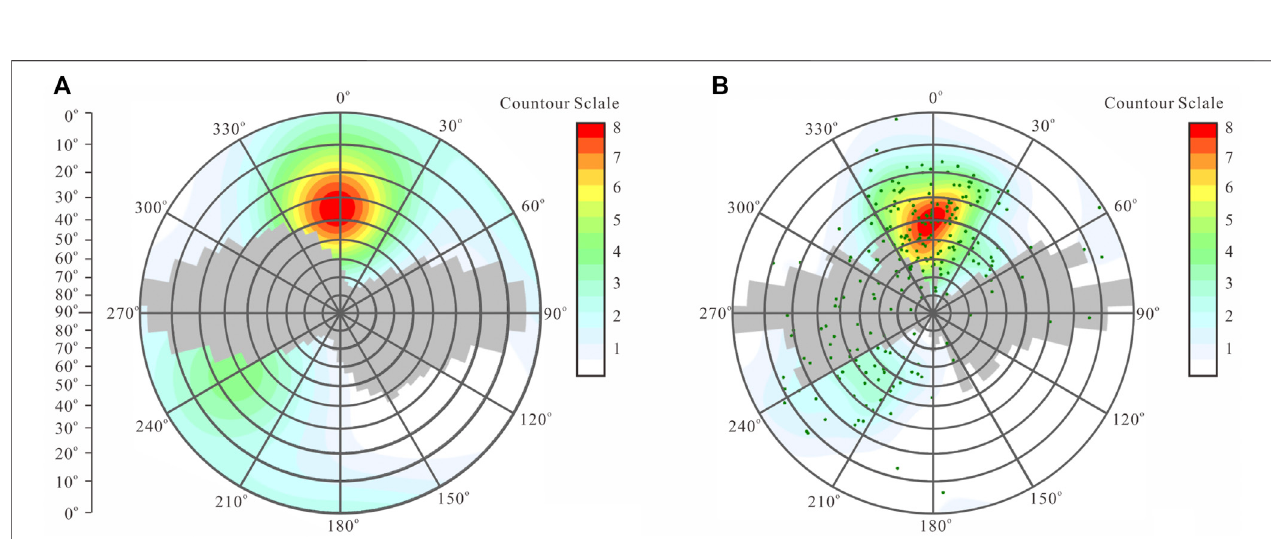
FIGURE 6 | (A) Rose diagrams of all of the fractures in the DFN model, and (B) the fractures that cut through well D22.